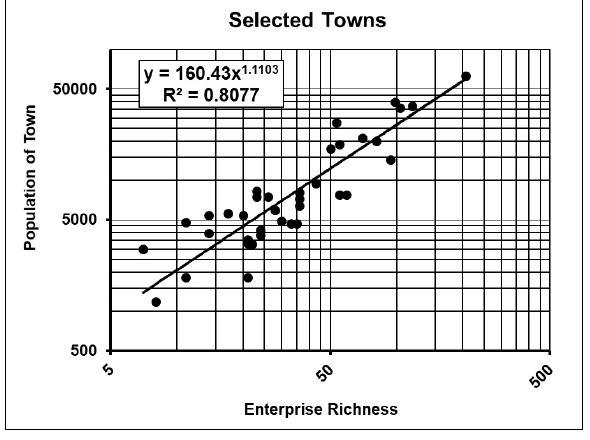
Figure 3: The power law (log-log) relationship between enterprise richness and the population numbers of enterprises in the towns selected for this investigation.